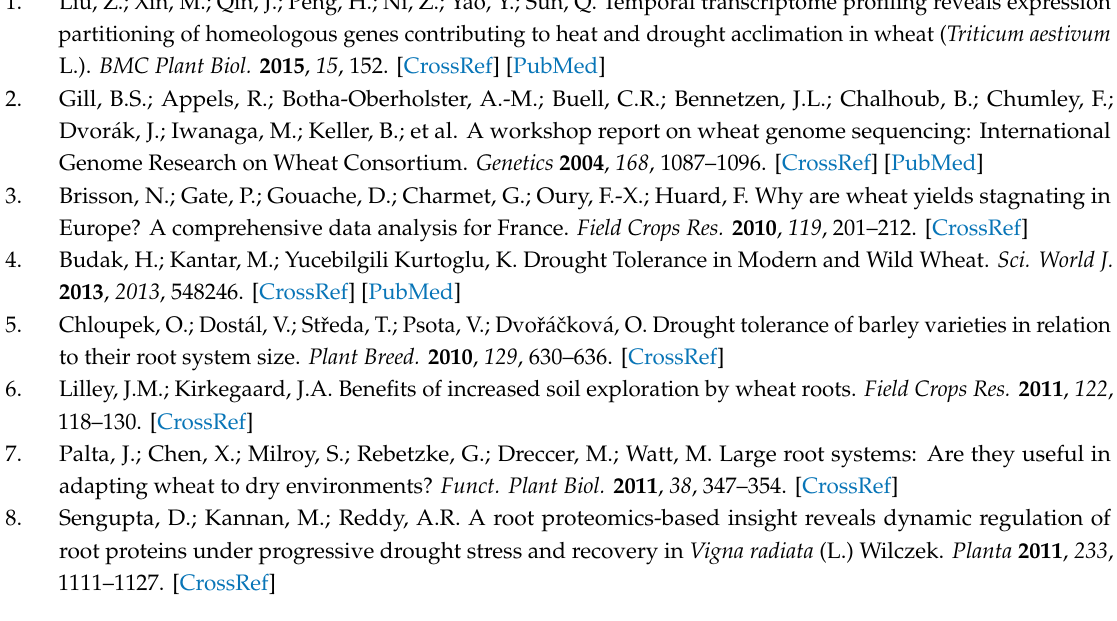
Figure S1A: Pearson’s correlation coe ffi cients and PCA plot analyses among biological replicates, Figure S1B: The expression profile of five triads detected via RNA-seq technique under water stress in Colotana.PEG vs. Colotana.con and Tincurrin.PEG vs. Tincurrin.con comparisons, Figure S2: qRT-PCR analysis of three index genes for high-salinity, heat, and cold stresses after a 6 h treatment in Colotana and Tincurrin, Table S1: Mapping of RNA-seq reads obtained from root samples into the reference Chinese_Spring_v1.0_pseudomolecules_parts. fasta genome sequence, Table S2: List of DEGs between Colotana.PEG and Colotana.con, Table S3: List of DEGs between Tincurrin.PEG and Tincurrin.con, Table S4: Designed PCR primers for qRT-PCR analysis, Table S5: Significantly enriched GO terms for up- and downregulated DEGs in Colotana and Tincurrin, Table S6: Significantly enriched KEGG pathways for up- and downregulated DEGs in Colotana and Tincurrin, Table S7: Complete list of identified variants between Colotana and Tincurrin, Table S8A: Homoeologous genes up / down regulated between Colotana.PEG vs. Colotana.con., Table S8B: Homoeologous genes up / down regulated between Tincurrin.PEG vs.